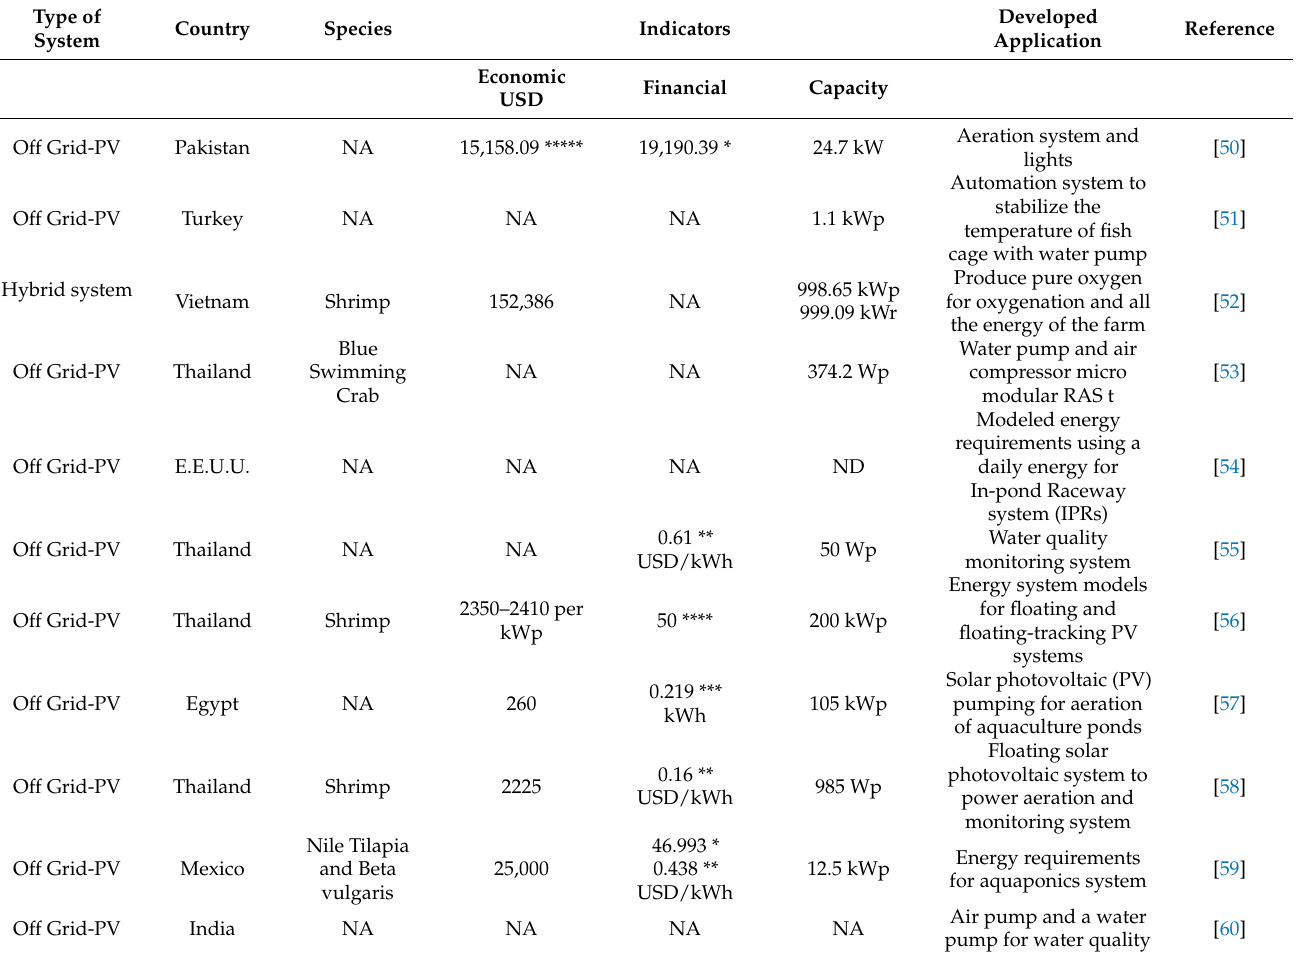
Table 1. Photovoltaic systems in the aquaculture in the empirical